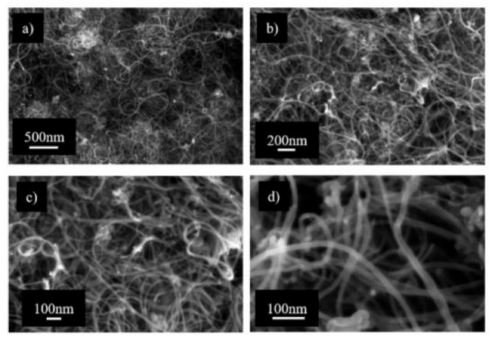
Figure 3. FESEM images of MWCNTs at different magnitudes: ( a ) 70 kX, ( b ) 130 kX, ( c ) 250 kX, ( d ) 500